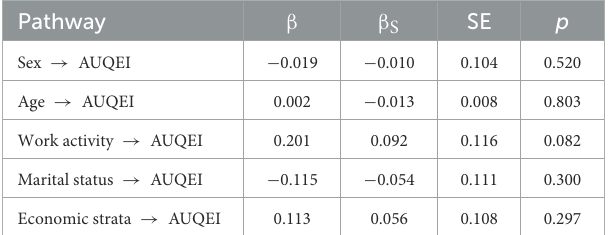
TABLE 3 Structural model for assessing demographic contribution to children’s subjective wellbeing